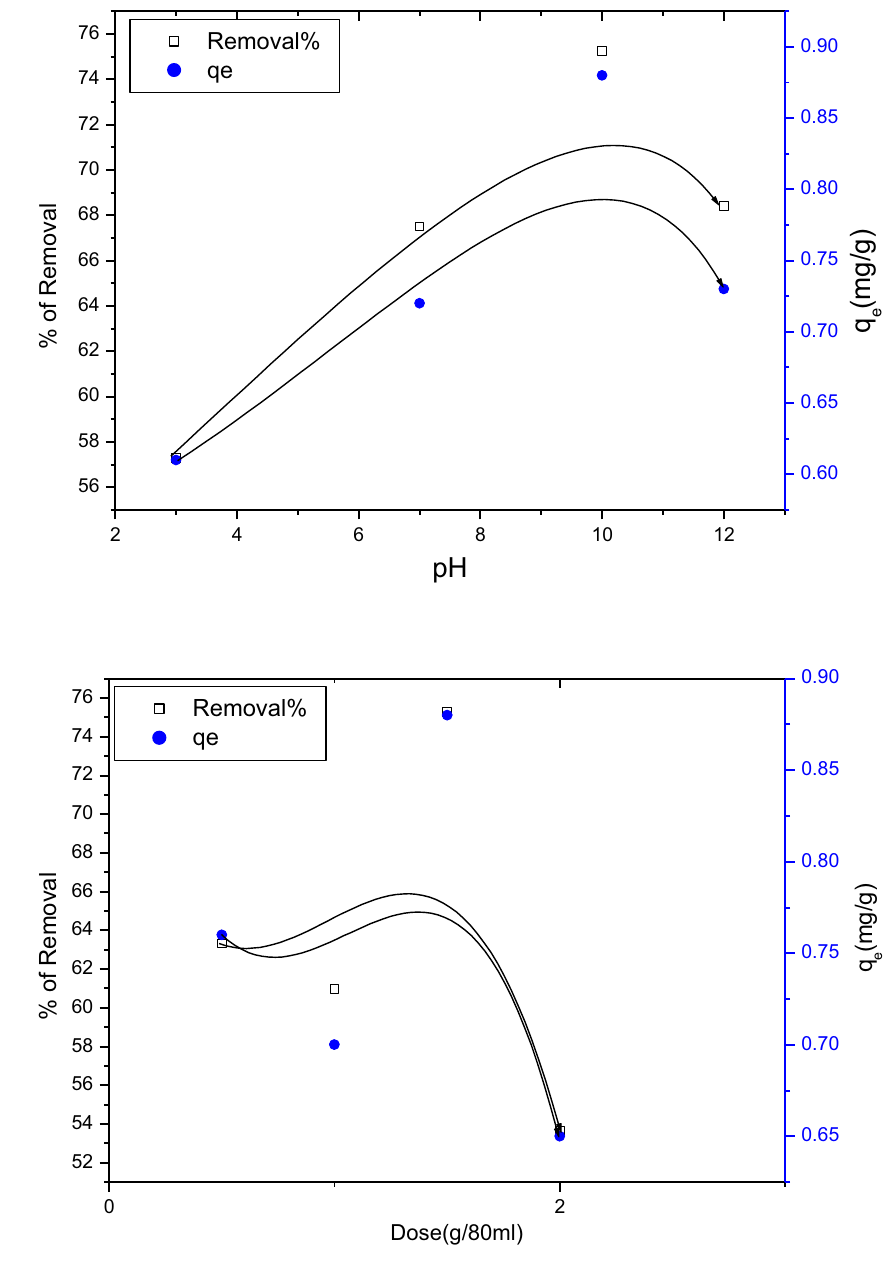
Fig. 5 Effect of pH on the adsorption of CR dye by the banana peel